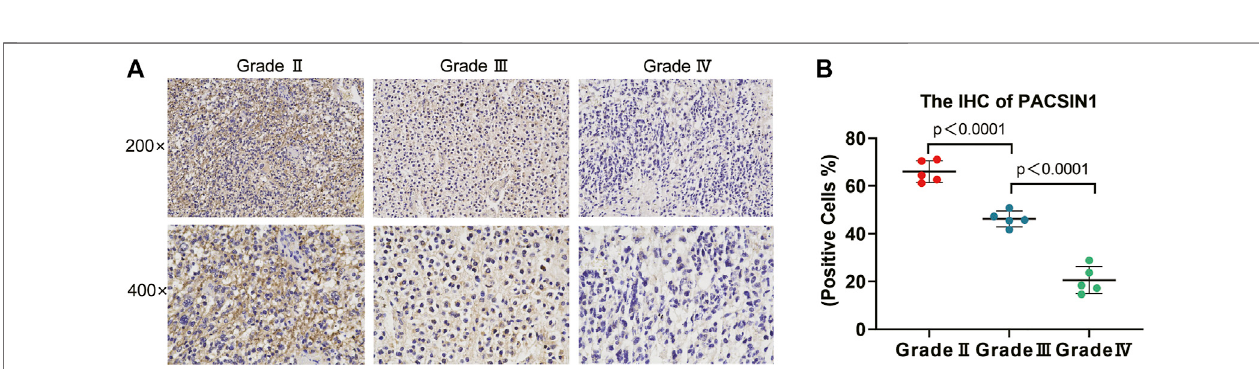
FIGURE 2 | PACSIN1 IHC results in different grades. PACSIN1 protein expression staining results (semi-quantitative scoring, expression intensity × expression area): upper, × 200; lower, × 400 (A) suggested that PACSIN1 protein expression downregulated with the progression of grades (B) . Blue purple represents the nucleus stained with hematoxylin and brown yellow represents the expression of